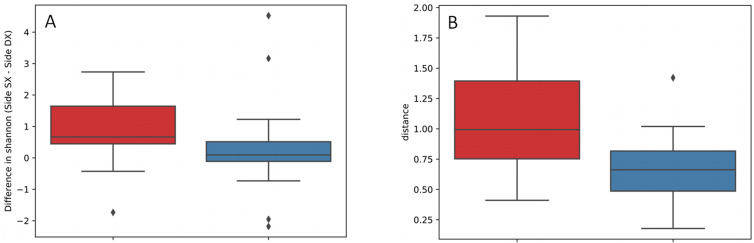
Apha and beta diversity analysis between the two ears from the same animal.Paired differences and distances between right and left ear from the same animal in healthy and otitis affected dogs: (A) Shannon index (P = 0.057); (B) weighted UniFrac matrix (P = 0.021).